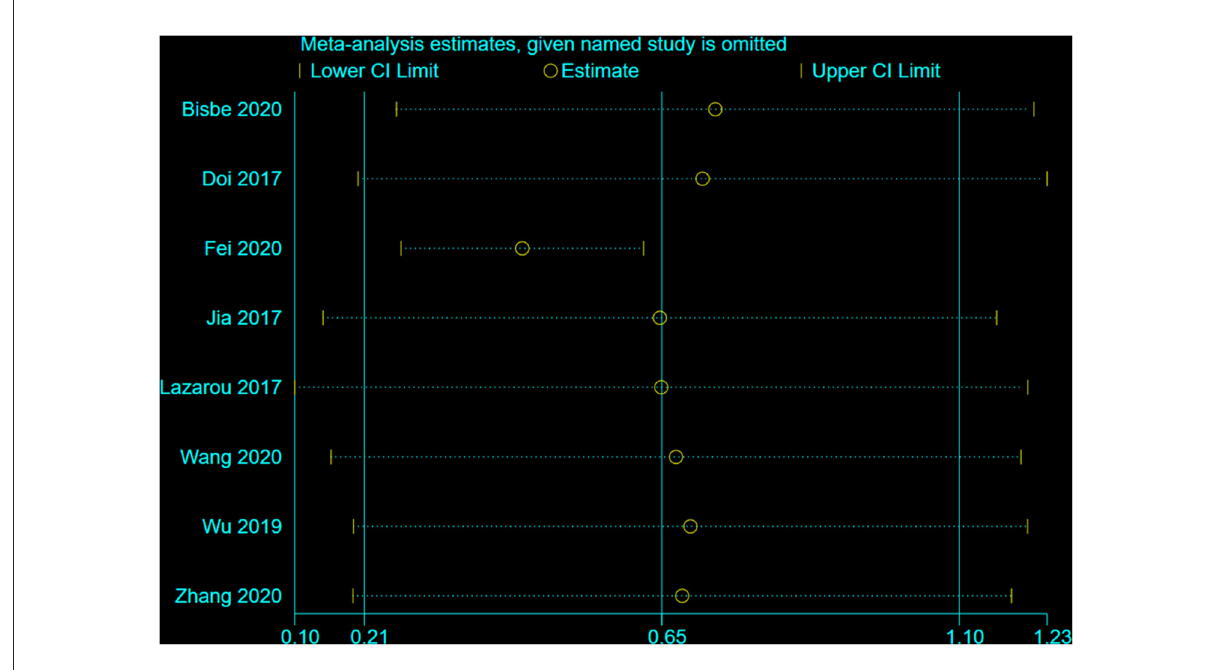
FIGURE9 The influence of each study on the outcome of the meta-analysis (MMSE).